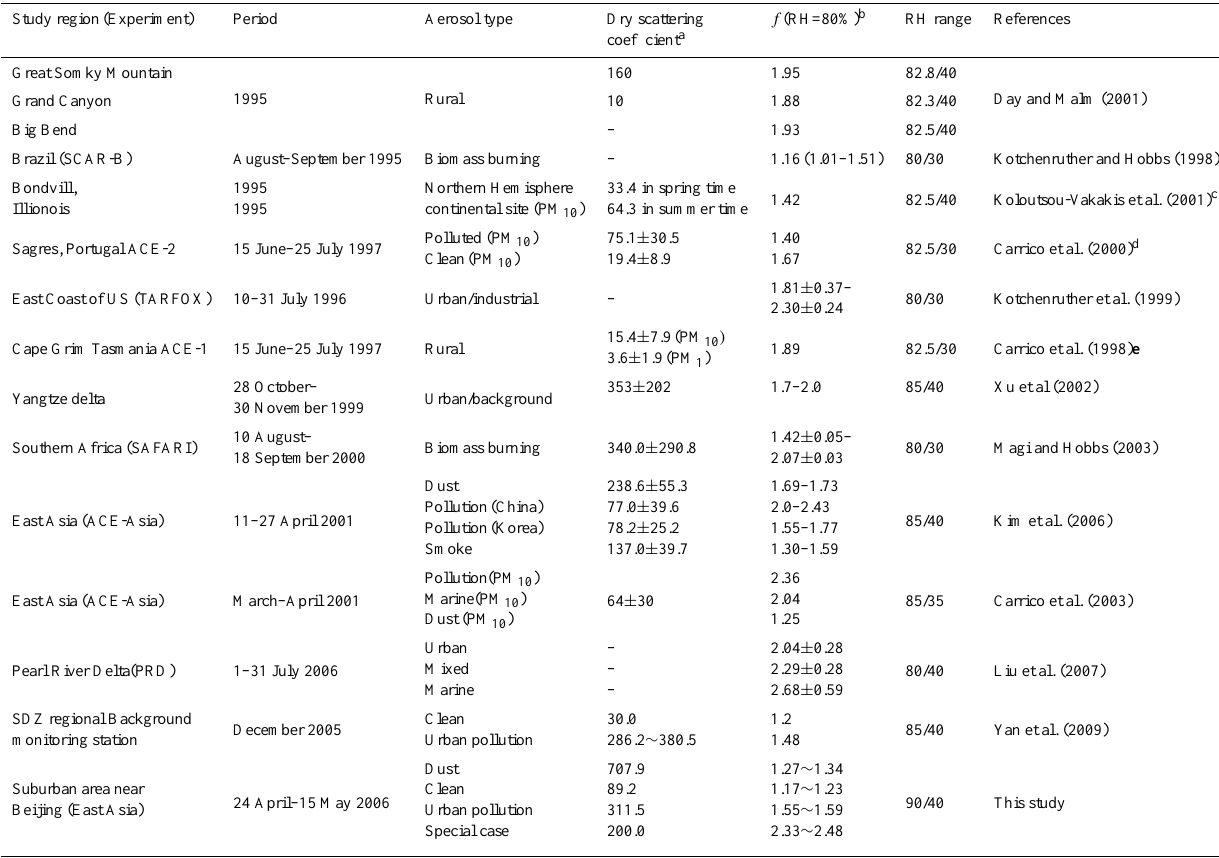
Table 3. Other observation results of hygroscopic growth factor of scattering coefficient for different categories of